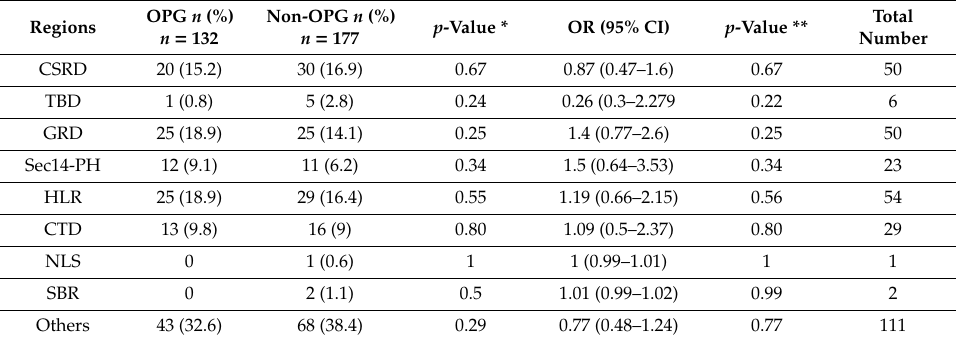
Table 3. Mutations in di ff erent NF1 gene regions and the risk of developing OPG.